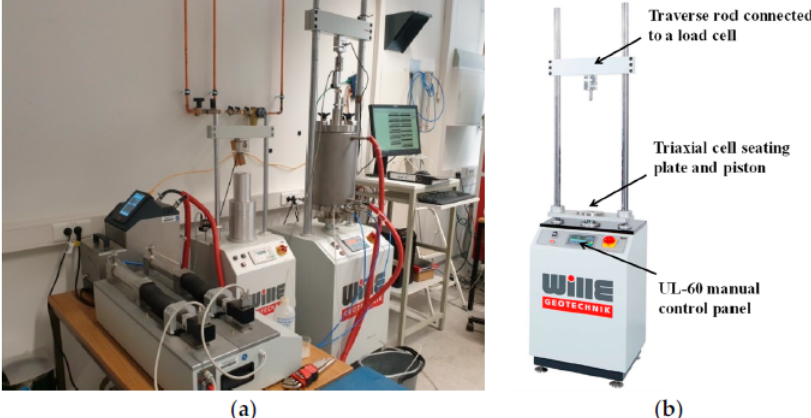
Figure 5. Triaxial testing apparatus used in testing the till soils: ( a ) complete set-up; ( b ) UL-60 loading machine.